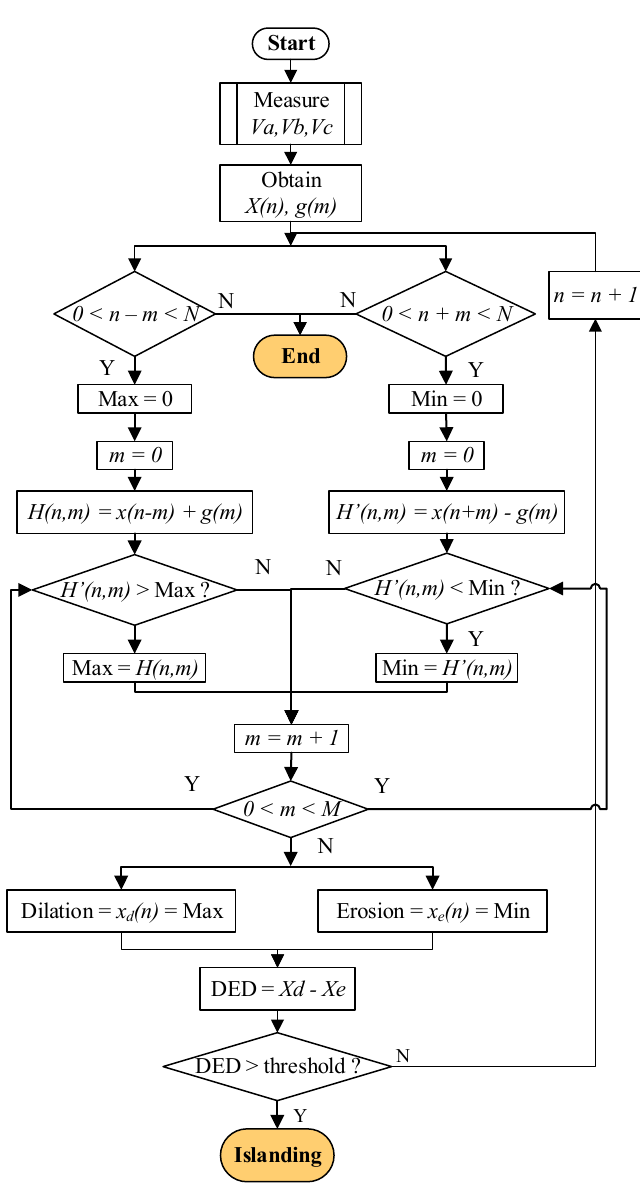
Figure 3. Flowchart of the proposed algorithm. Figure 4. Flowchart of the proposed